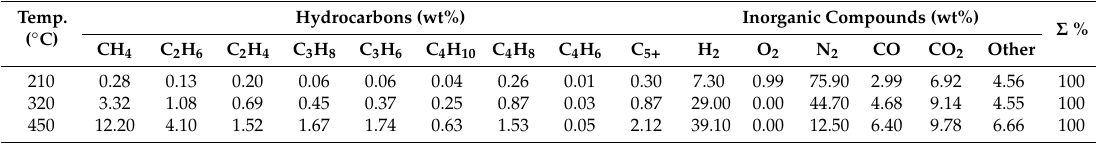
Table 7. Gas composition, postconsumer material, 450 ◦